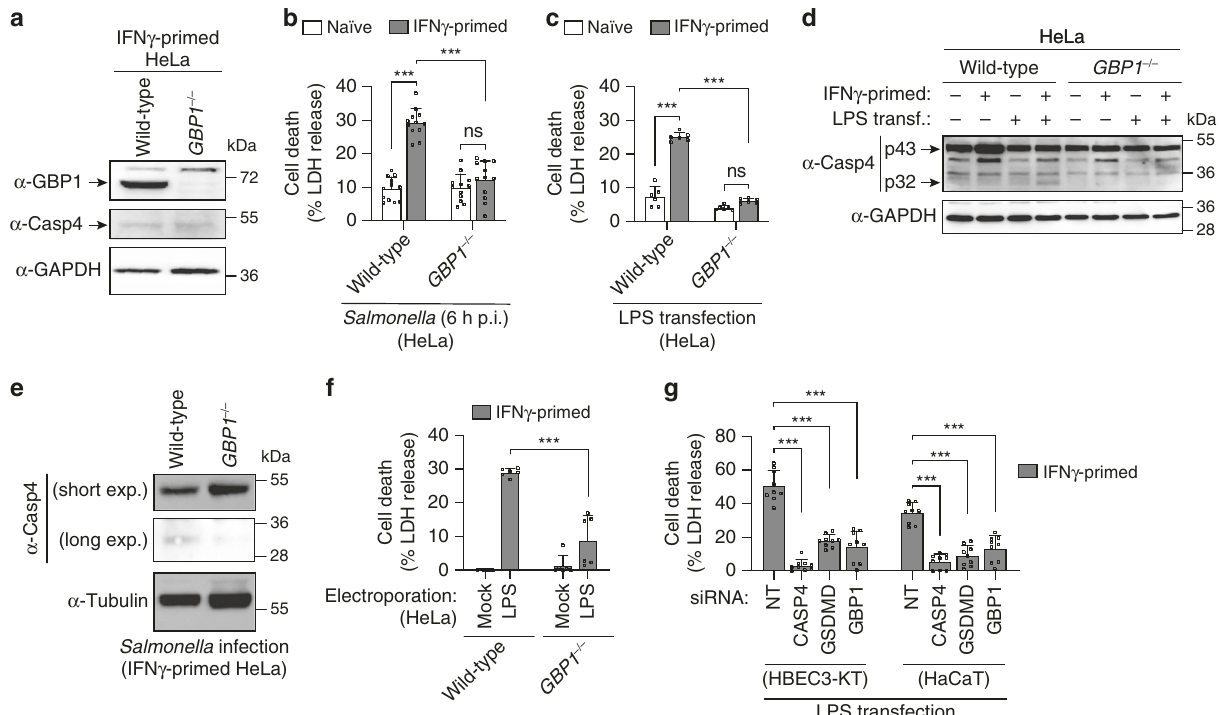
Fig. 2 GBP1 is required for Salmonella - and LPS-induced caspase-4 activation to induce pyroptosis in epithelial cells. a Immunoblots for GBP1, caspase- 4 and GAPDH (loading control) in cell lysates from IFN γ -primed wild-type or GBP1 – / – HeLa. b , c Release of LDH from naive or IFN γ -primed wild-type or GBP1 – / – HeLa after Salmonella infection ( b ) or after 5 h transfection with E. coli LPS (2.5 µ g / 50,000 cells) ( c ). d , e Immunoblots for full length (p43) and cleaved (p32) caspase-4 in combined supernatants and cell lysates from naive or IFN γ -primed wild-type and GBP1 – / – HeLa, upon transfection with E. coli LPS for 5 h ( d ) or Salmonella infection ( e ). f Release of LDH from IFN γ -primed wild-type or GBP1 – / – HeLa, 3 h after electroporation with LPS (300 ng/ 50,000 cells). g Release of LDH in IFN γ -primed HBEC3-KT or HaCaT cells treated with non-targeting control siRNA (NT) or with siRNAs targeting CASP4 , GSDMD or GBP1 , after E. coli LPS transfection. Cells were treated with siRNAs for 24 h and transfected with LPS (2.5 µ g / 50,000 cells) for 5 h. Graphs show the mean ± SD, and data are pooled from two ( c , f ), three ( g ) or four ( b ) independent experiments performed in triplicate, or representative of